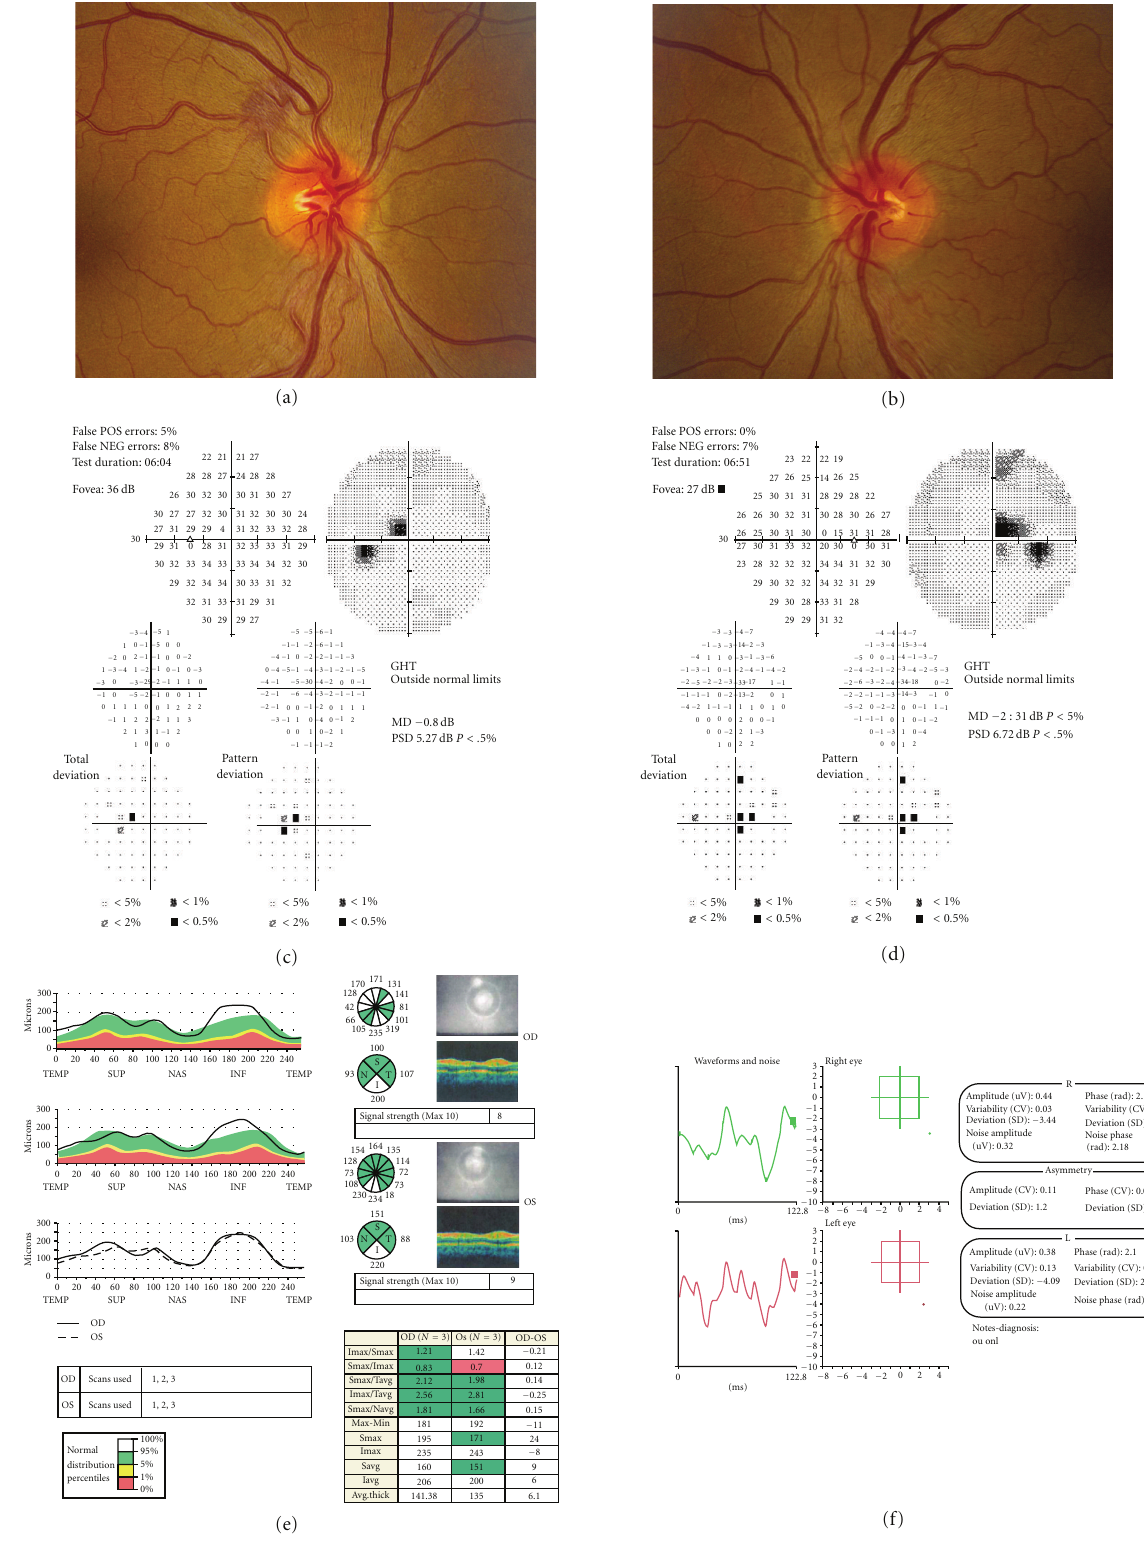
Figure 1: Fundus photographs of a patient with acute LHON revealed swelling of the right (a) and left (b) optic nerve heads. The arrow indicates the characteristic peripapillary telangiectasia. Automated visual fields showed central scotomas in the left (c) and right (d) eyes. OCT confirmed and quantitated the swelling of the retinal nerve fiber layer (e). Pattern electroretinograms illustrated a decline in ganglion cell function occurred during the acute stages of LHON and before structural evidence of RGC loss